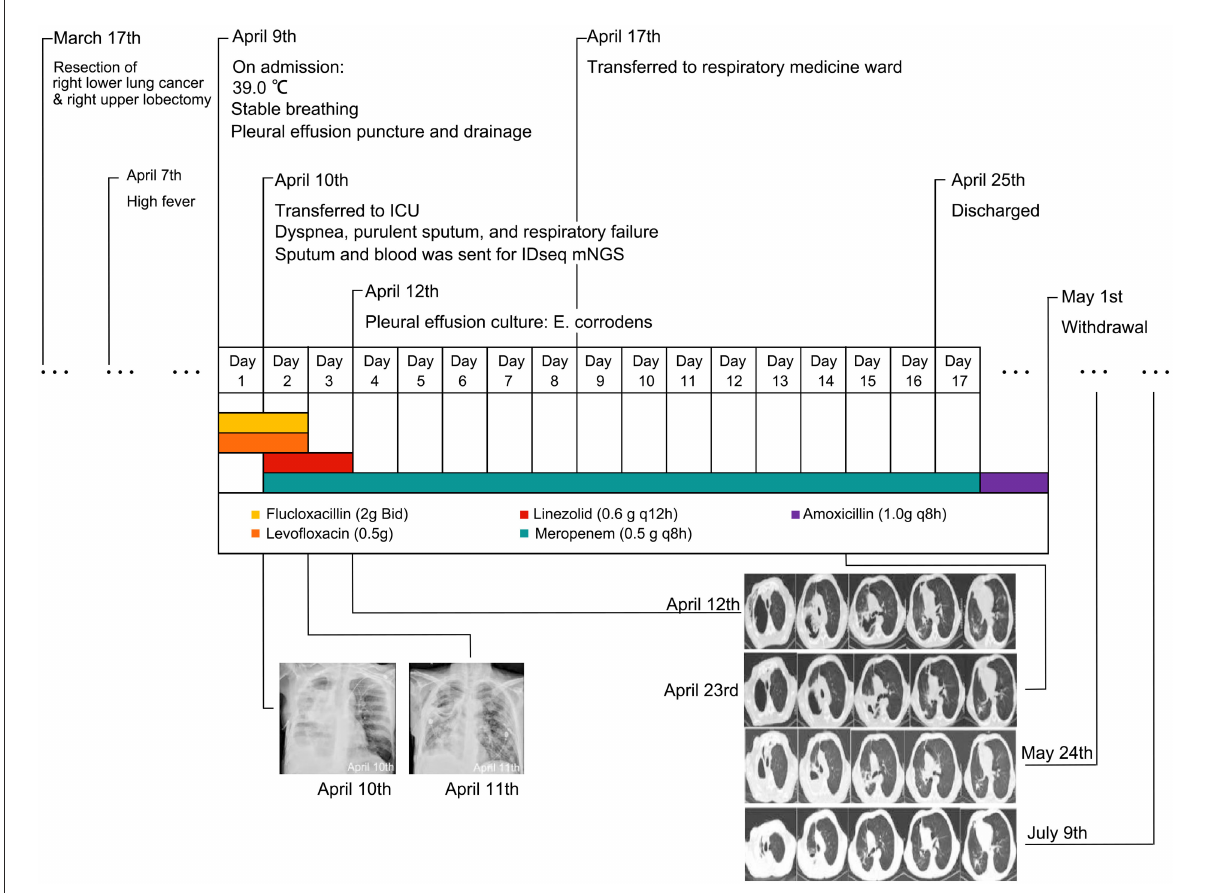
FIGURE1 The timeline of this patient. Bedside chest x-rays on 10 and 11 April revealed patchy high-density shadows with localized consolidation in the right lung field. Chest computed tomography (CT) showed the infection was continuously